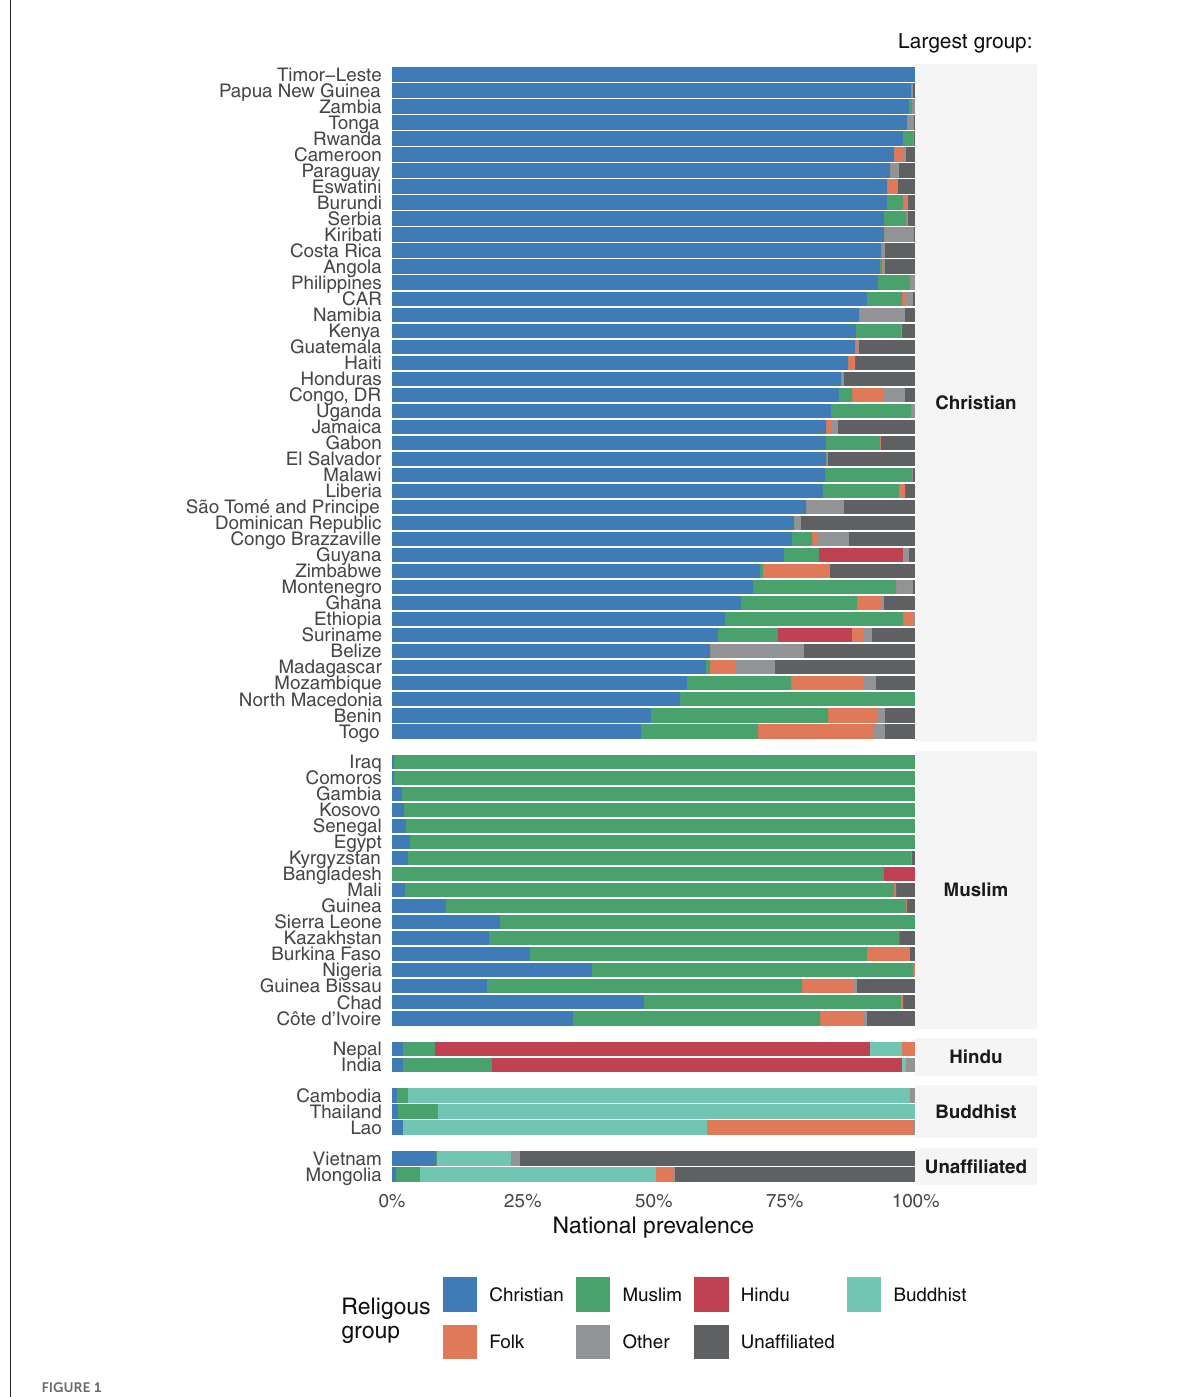
Buddhists and Hindus was no longer present, with higher no-DPT prevalence in both cases relative to Christians and a significant difference for Hindus. Higher prevalence relative to Christians was also observed for Muslim and